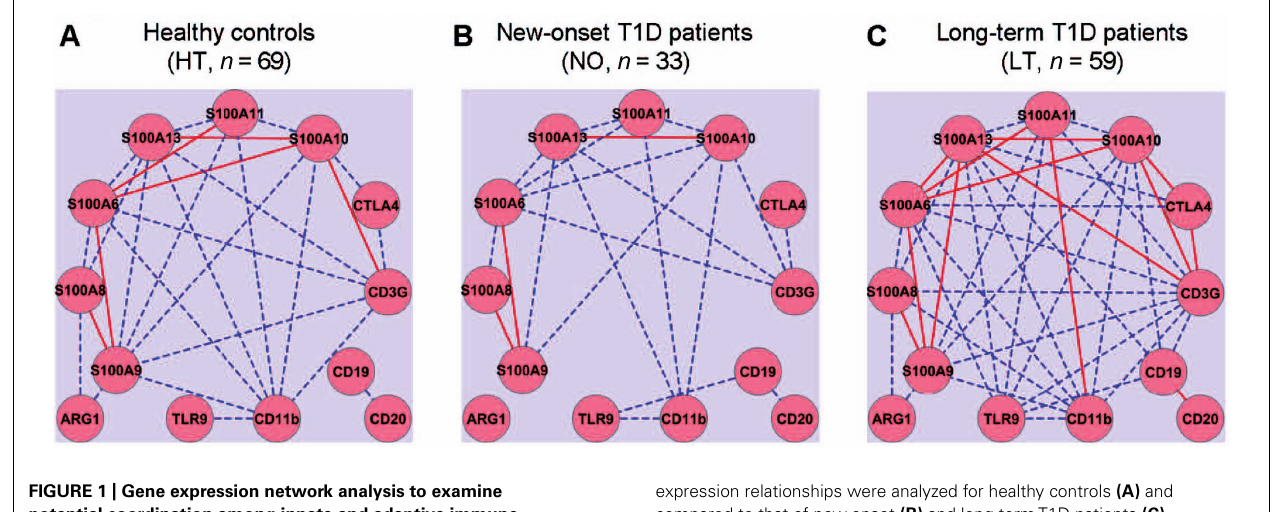
FIGURE 1 | Gene expression network analysis to examine potential coordination among innate and adaptive immune gene expression. Quantitative RT-PCR was used to assess the levels of mRNA expression for thirteen innate (CD11b,TLR9, and S100 family) and adaptive (CD3, CTLA4, CD19, and CD20) immune genes. Gene